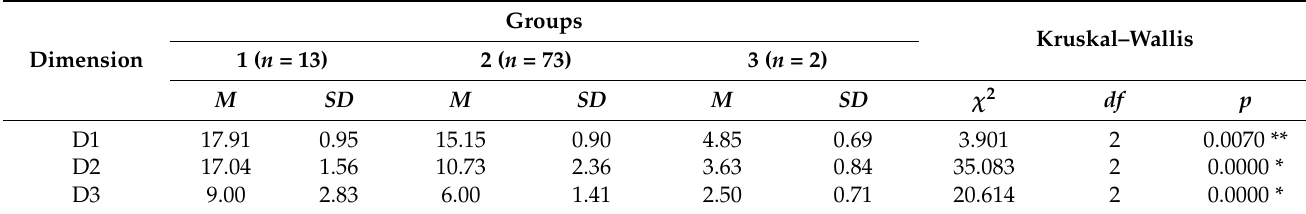
Table 3. Statistically significant differences in the dimensions according to the groups of the apps.